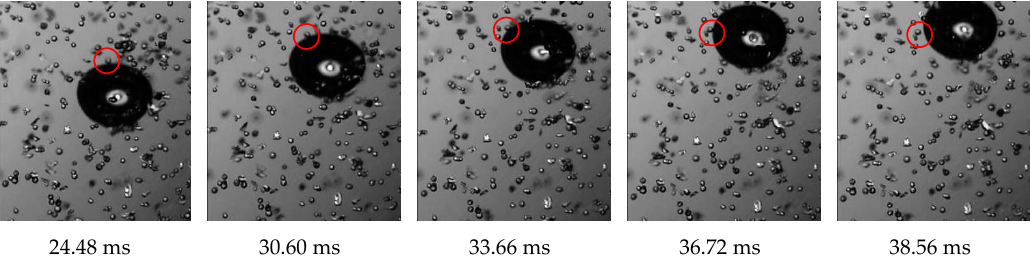
Figure 12. Detachment of glass microspheres from bubbles.